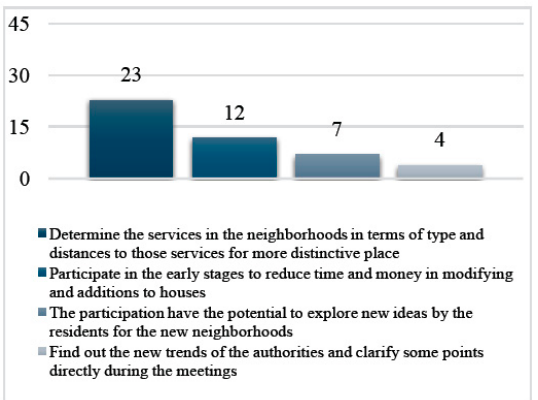
Figure 7. Justification of the importance of community participation by the interviewed Emirati